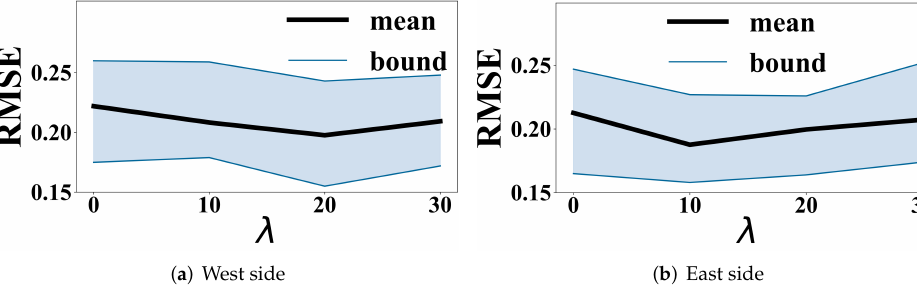
Figure 5. The influence of λ .